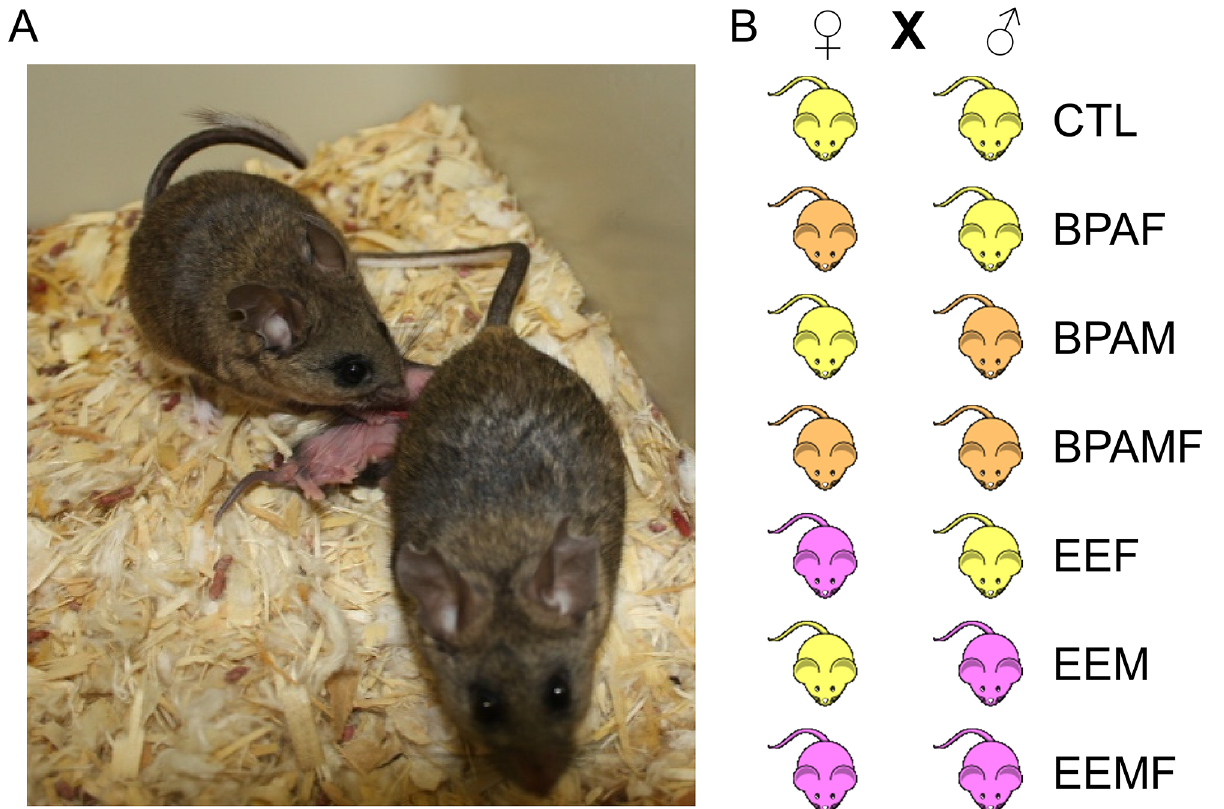
Fig 1. Typical image of a pair of California mice with two pups. Pups most frequently nurse from the caudally located mammary glands, while the male trails behind the female while simultaneously grooming the pups. The pairing combinations are also